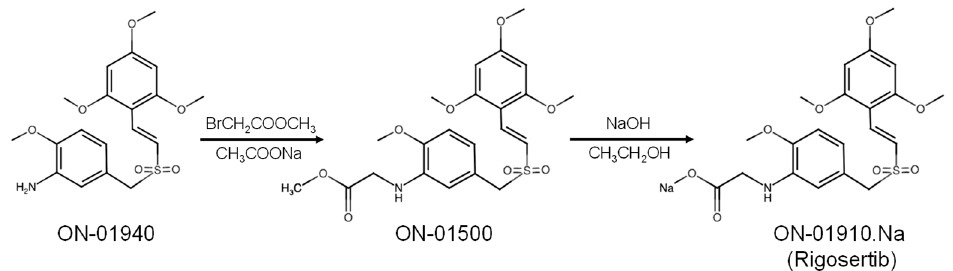
Figure 1. Scheme of development of the rigosertib molecule. Images generated using chemaxon.com/marvin (accessed on 25 January 2023) .